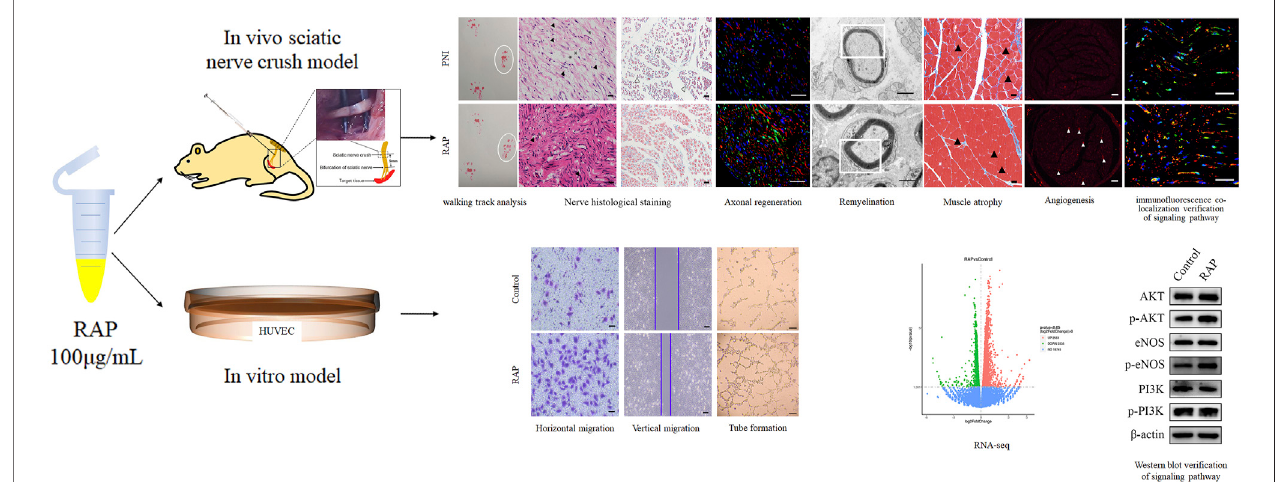
FIGURE 9 | Schematic diagram of the study. In vitro , RAP promoted EC migration and tube formation. RNA-seq and WB revealed that RAP may accelerate angiogenesis by activating AKT/eNOS signal pathway. In vivo , RAP promoted functional recovery, delayed target organ atrophy, improved neuropathological morphology and remyelination after PNI, and could accelerate angiogenesis by activating AKT/eNOS signaling pathway.